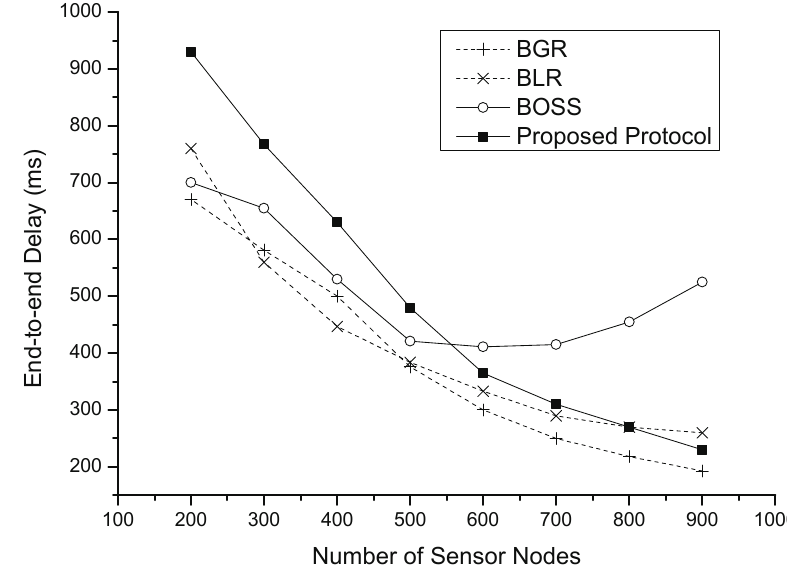
Figure 12. The end-to-end delay vs. the number of sensor